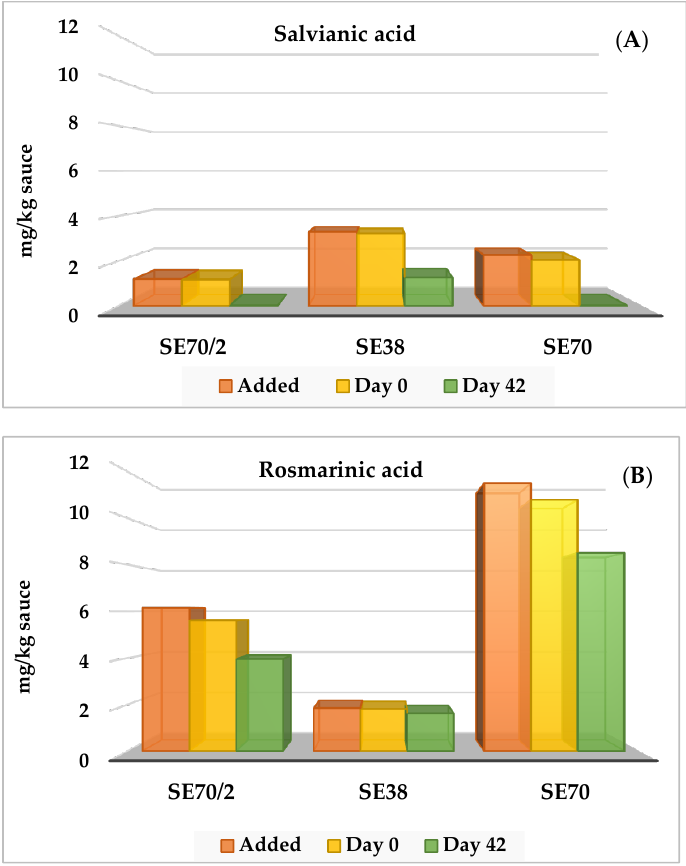
Figure 2. Added (raw sauce) and remaining quantities (mg/kg) of salvianic ( A ) and rosmarinic ( B ) acids in yoghurt sauces enriched with sage extracts (SE70/2, SE38 and SE70) and kept at 4 °C for 42 days. Standard Error of the Mean: Salvianic acid: 0.021 (SE70/2), 0.088 (SE38), and 0.018 (SE70); Rosmarinic acid: 0.204 (SE70/2), 0.034 (SE38), and 0.394 (SE70).